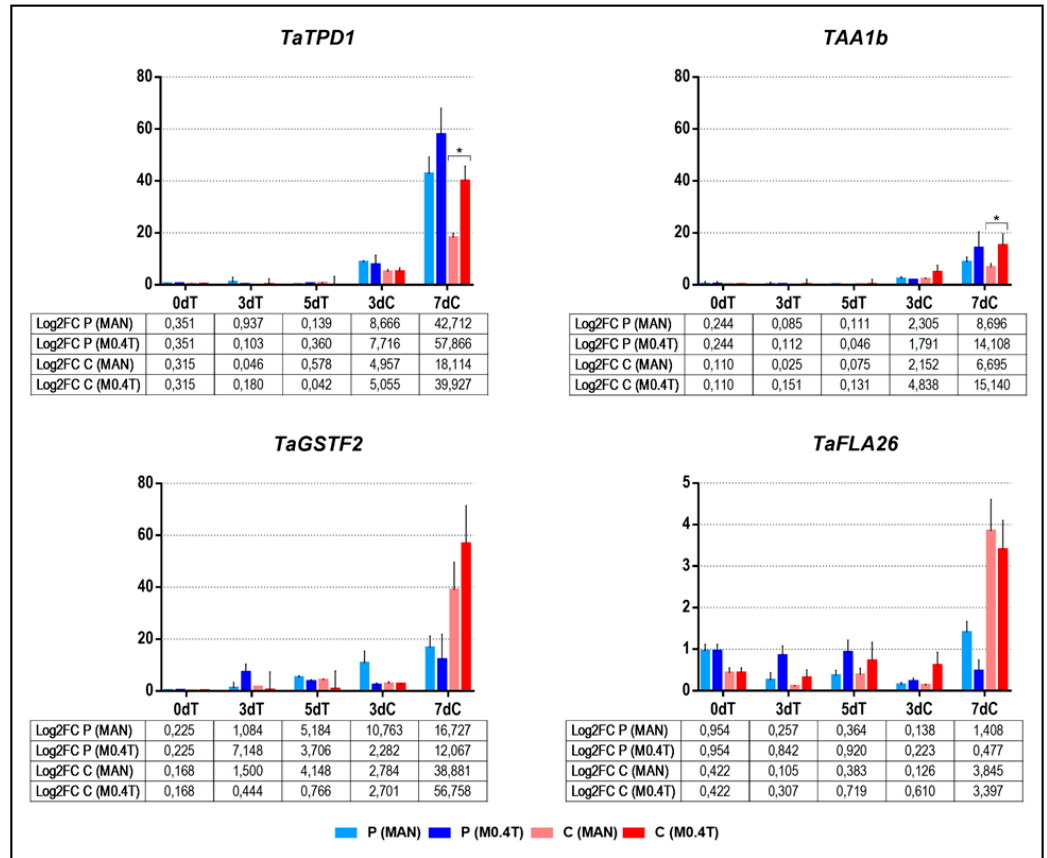
Figure 4. qRT-PCR analysis of early ( TaTPD1 , TAA1b and TaGSTF2 ) and middle ( TaFLA26 ) marker genes for bread wheat microspore embryogenesis after application of treatments with 0.7 M mannitol (MAN) and mannitol with 0.4 µM TSA (M0.4T) in cvs. Pavon (P) and Caramba (C) after 0, 3, and 5 days of treatment (0dT, 3dT, and 5dT) and 3 and 7 days of culture (3dC and 7dC). The y-axis shows the log2 fold-change when the data was normalized using Ta27771 as endogenous gene control. Error bars represent the standard error of the means. Asterisk indicates significant differences between treatments for each cultivar, according to a Student´s t -test ( p ˂ 0.05).